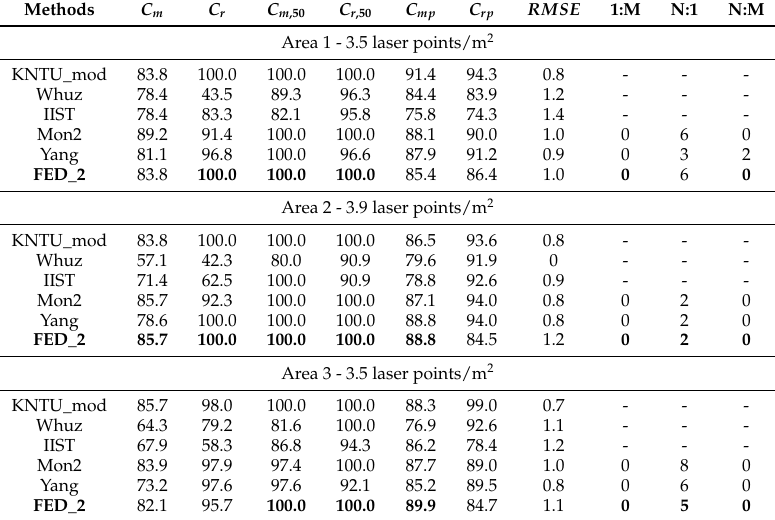
- means results not available. Comparing building detection results for the Australian data set. Object-based C m = completeness, C r = correctness ( C m ,10 and C r ,10 are for buildings over 10 m 2 ) and pixel-based C mp = completeness and C rp = correctness are in percentage. RMSE = planimetric accuracy in metres. Bold values show better or equal performance of the proposed